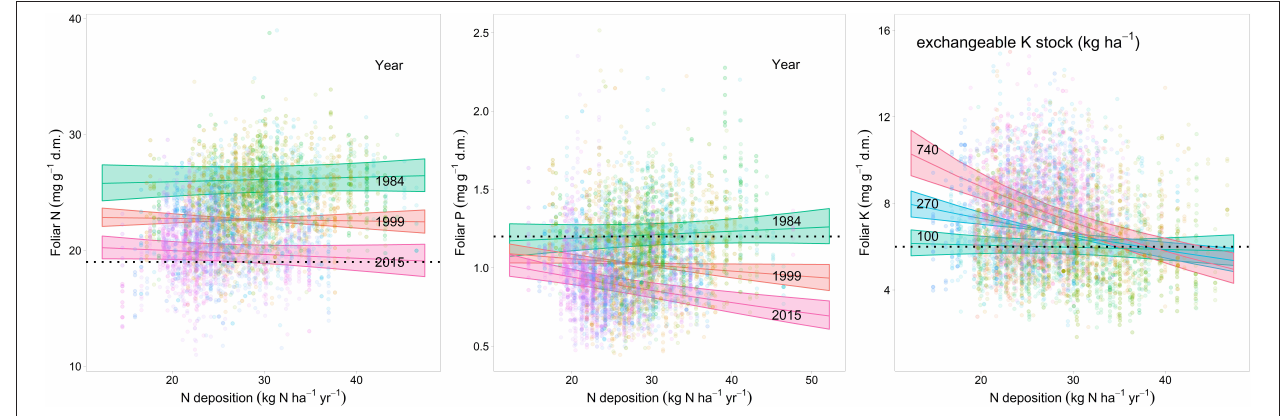
FIGURE 4 | Relationship between modeled N deposition and N (left), P (center), and foliar K concentrations (right) in Fagus sylvatica . Predicted values extracted from the regression models for 3 years (N, P) and for three levels of soil K stock (K). The lower thresholds to normal nutrition according to Göttlein (2015) are given as dashed lines. The colored bands indicate the 95% confidence intervals.